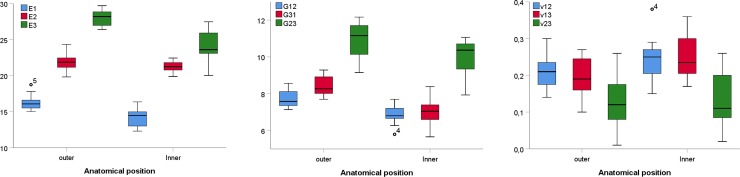
Principal elastic mechanical properties for baboons in the three-layered calvarial system.(A) Elastic moduli, (B) shear moduli, and (C) Poison´s ratios.